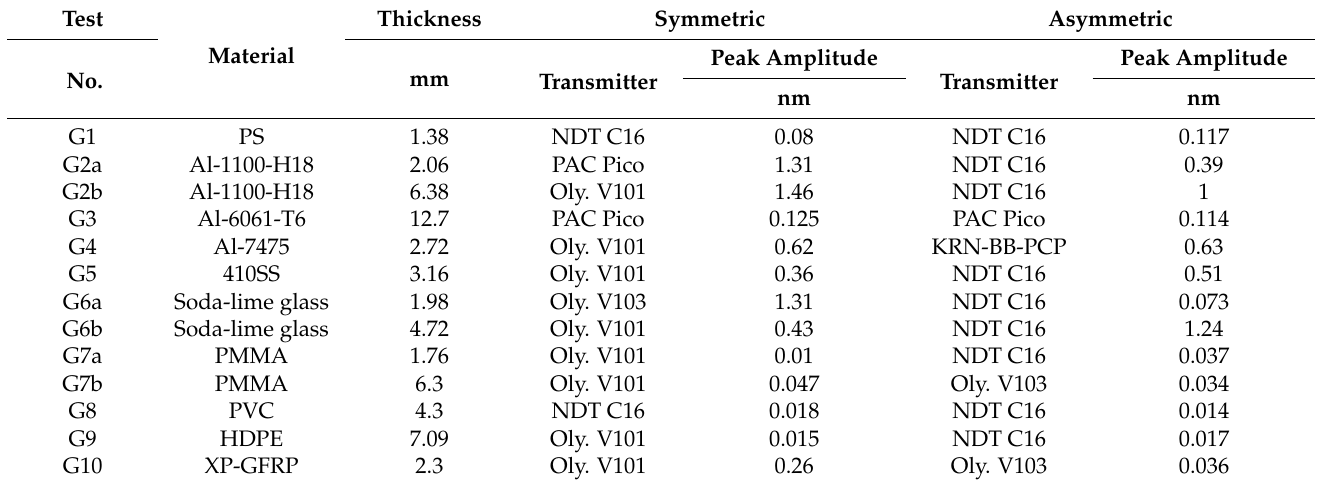
Table 3. Peak displacement of detected Lamb-wave signals using a point contact sensor